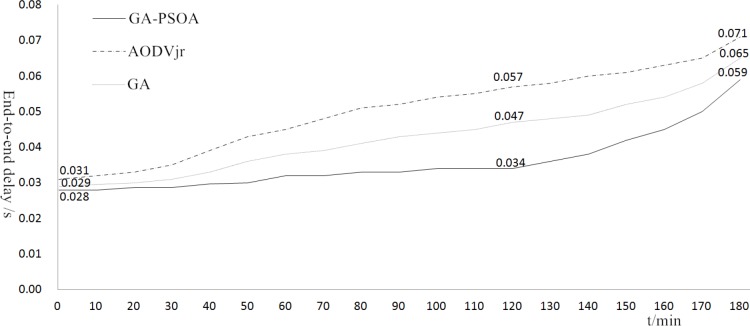
End-to-end delay.